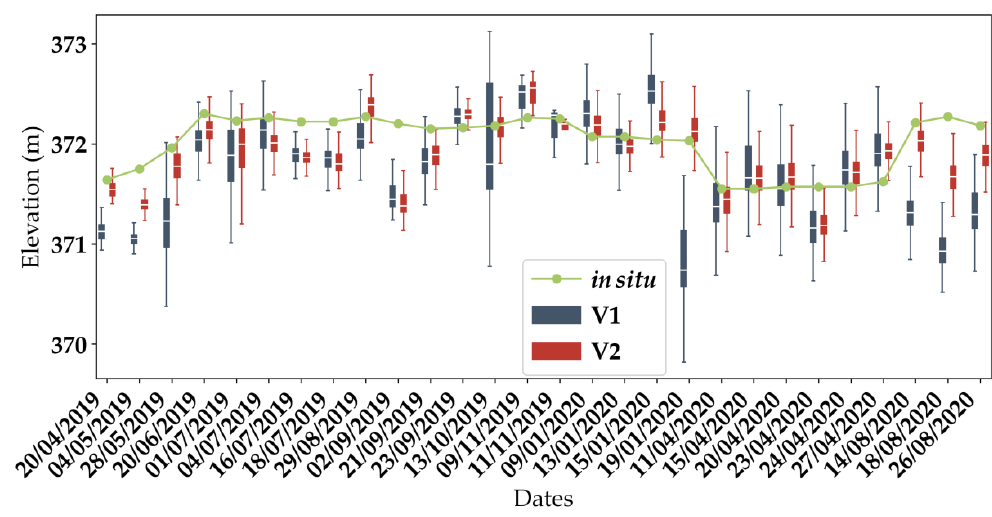
Figure 12. Box-whiskers plot by date of the estimated elevations by GEDI’s first (blue) and second (red) data product releases. The green line represents in situ elevations. For each date, the V1 and V2 box plot locations were moved to 12 h before and 12 h respectively after the acquisition for better visibility.